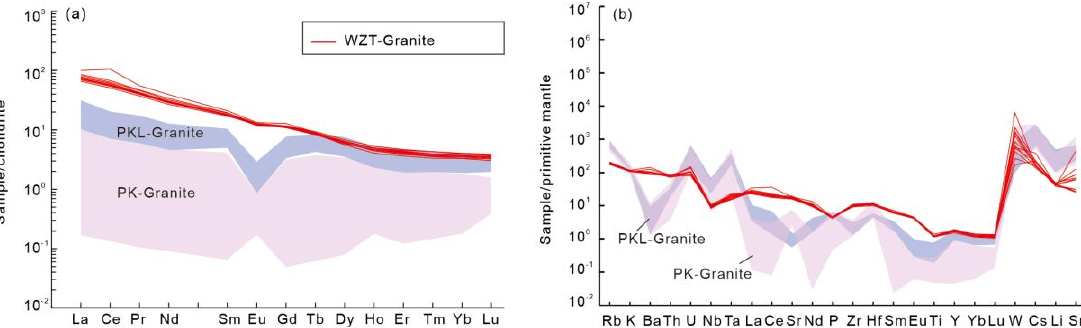
Figure 7. ( a ) Chondrite-normalized REE distribution patterns and ( b )primitive mantle-normalized trace element spider diagrams of the Wuzhutang granite from the Xuebaoding mining area, Sichuan Province, China. Data for the chondrite and primitive mantle are computed from [58], and data of the Pankou and Pukouling granites are from [38,39].